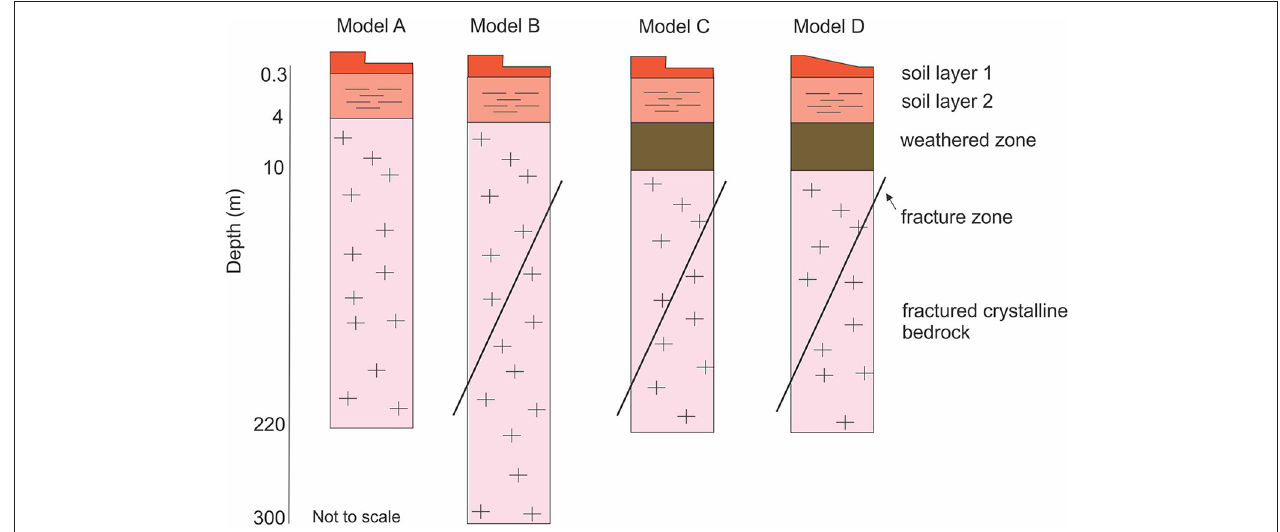
FIGURE 3 | Schematic of the four conceptual models explored using a numerical hydrological model. (Model A) 2-layer soil zone overlying homogeneous bedrock to a depth of 250m; (Model B) 2-layer soil zone, overlying heterogeneous bedrock (with fracture zones) to a depth of 300m; (Model C) 2-layer soil zone, 10-m thick weathered zone, heterogeneous bedrock (with fracture zones); (Model D) 2-layer soil zone, 10-m thick weathered zone, heterogeneous bedrock (with fracture zones) with the ground surface based on the LiDAR-derived